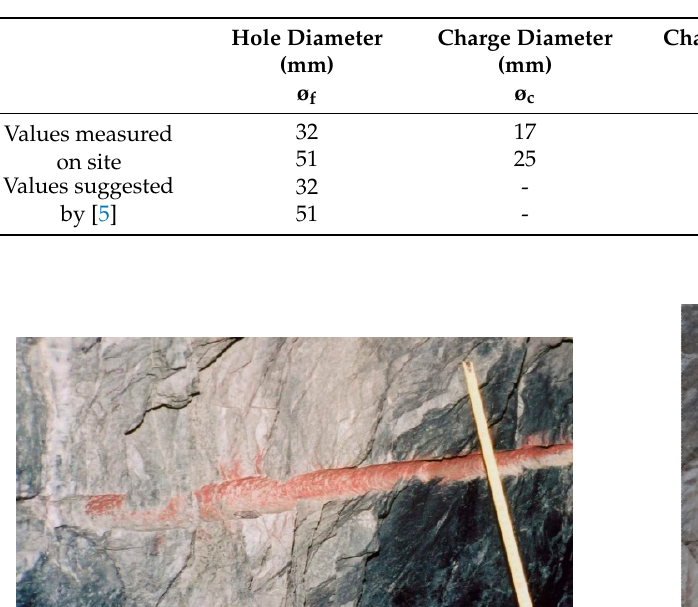
Table 2. Common parameters adopted to size the smooth blasting.